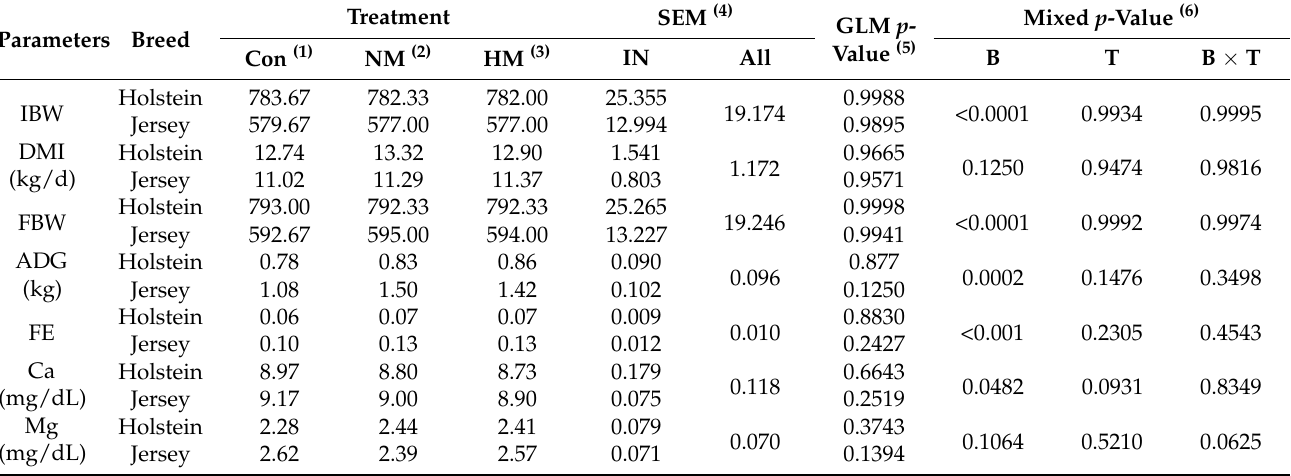
Table 3. Growth performance, serum biochemistry, trace mineral, superoxide dismutase (SOD), and heat-shock proteins (HSPs) concentrations of Holstein and Jersey steers supplemented with different concentration of